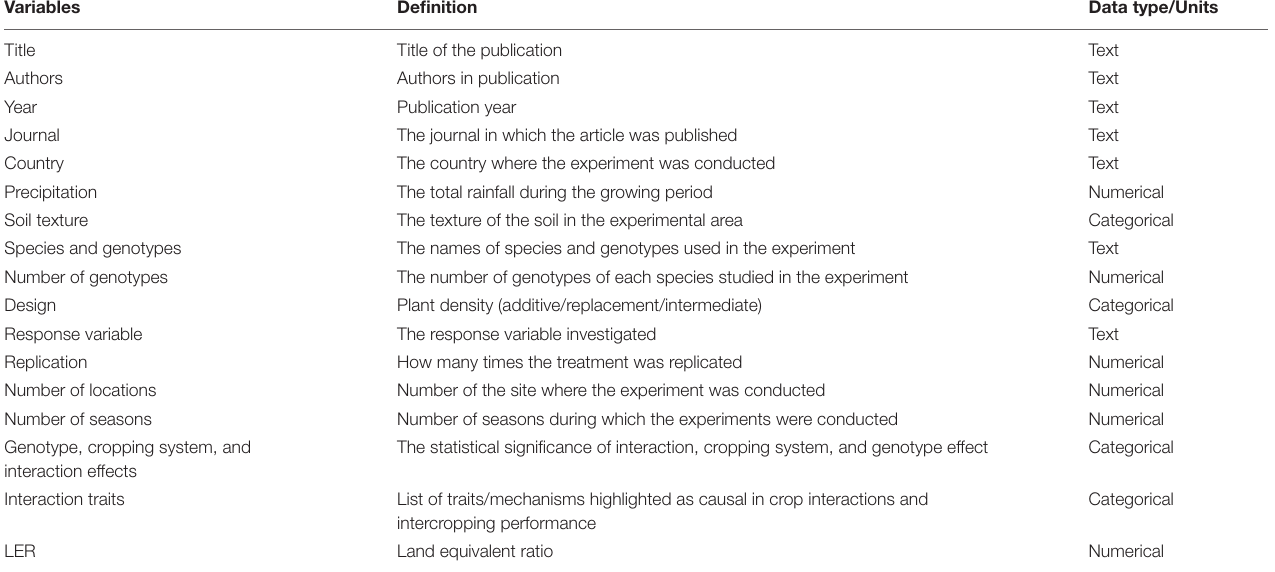
TABLE 1 | Variables extracted from different